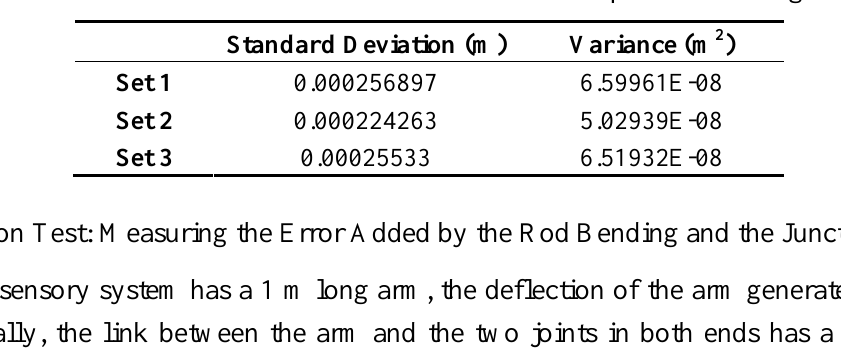
Table 3. Standard deviation and variance of the data presented in Figure